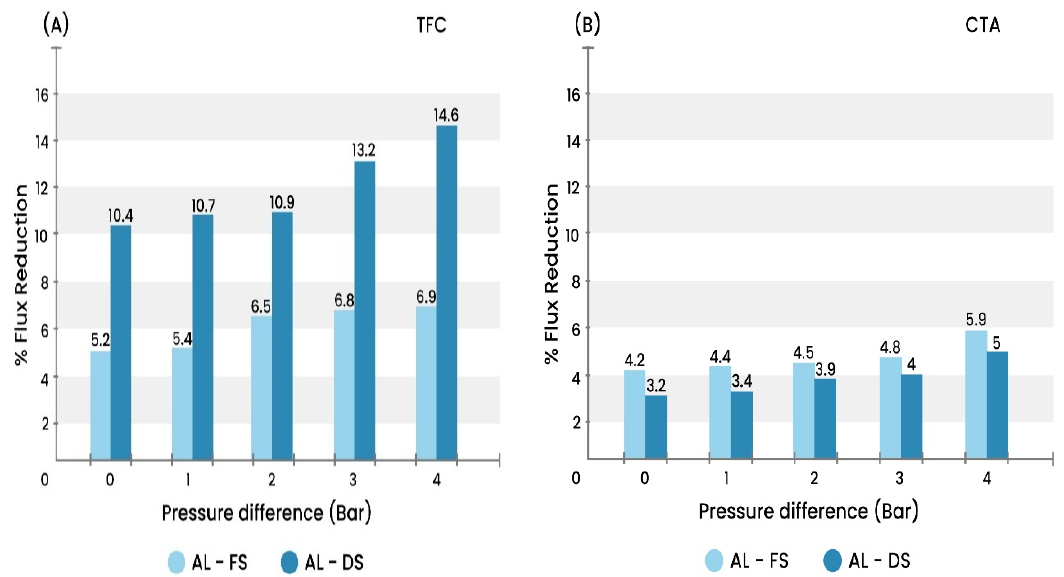
Figure 7. Flux reduction in the FO process at different applied pressures using ( A ) TFC membrane and ( B ) CTA membrane in both AL-FS and AL-DS orientations.